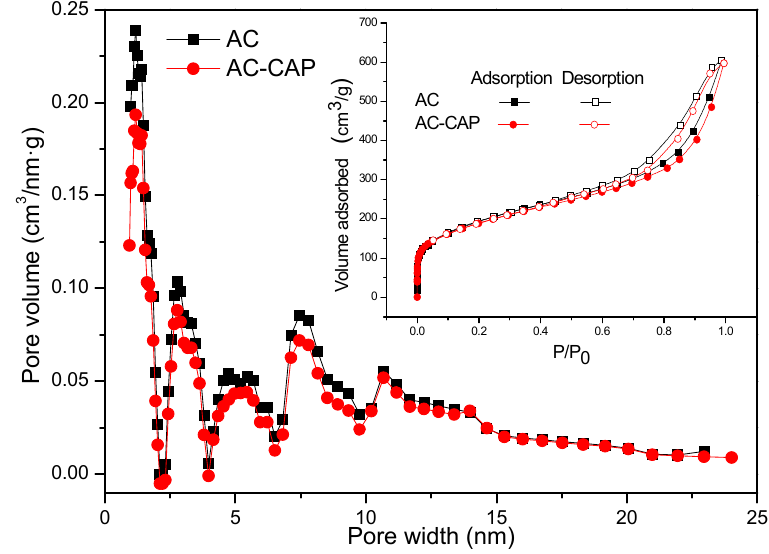
Figure 2. Pore size distribution and N 2 adsorption/desorption isotherm (insert) of AC before CAP adsorption and AC after CAP adsorption (AC-CAP). The pore size distribution was determined by the Density Functional Theory (DFT) method. Table 2. The yield and textural characterization before and after CAP adsorption of AC.